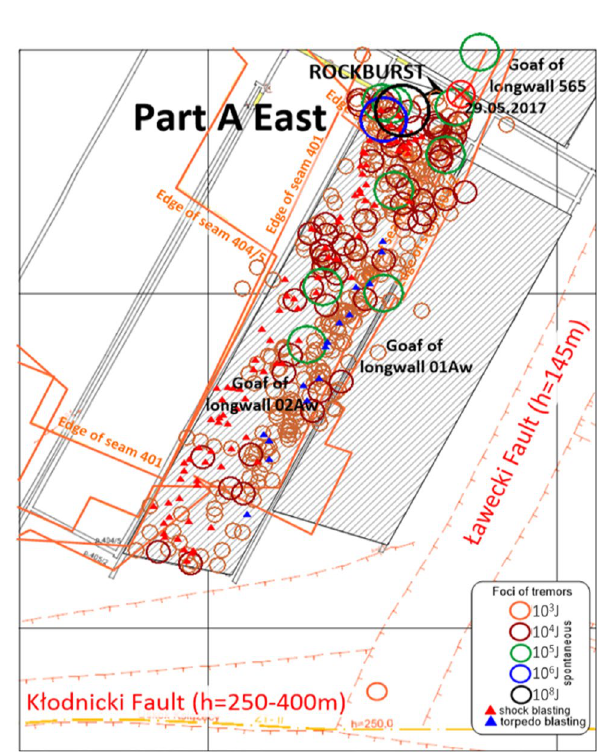
Fig. 3 Distribution of seismic epicentres in the longwall 02Aw